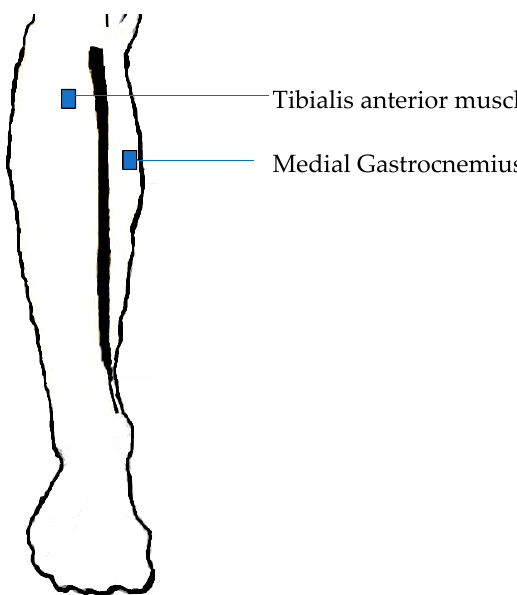
Figure 1. Location of the sensor on the right leg Figure 1 . Location of the sensor on the right leg [48].